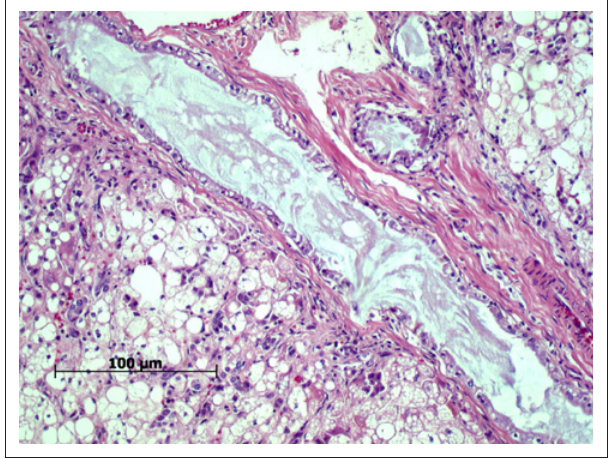
FIGURE 3: A very characteristic microscopical finding (in 24 out of 31 cases) in canine aflatoxicosis was the presence of a blue-grey material within the bile ductules and ducts.